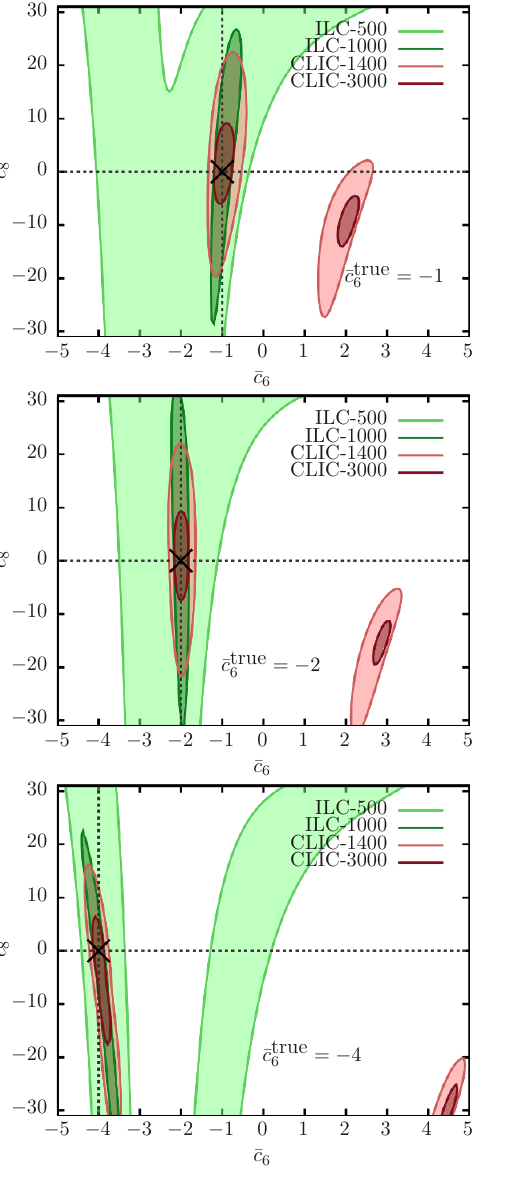
= (cid:0) 4 ; (cid:0) 2 ; (cid:0) 1 ; 1 ; 2 ; 4 marked 6